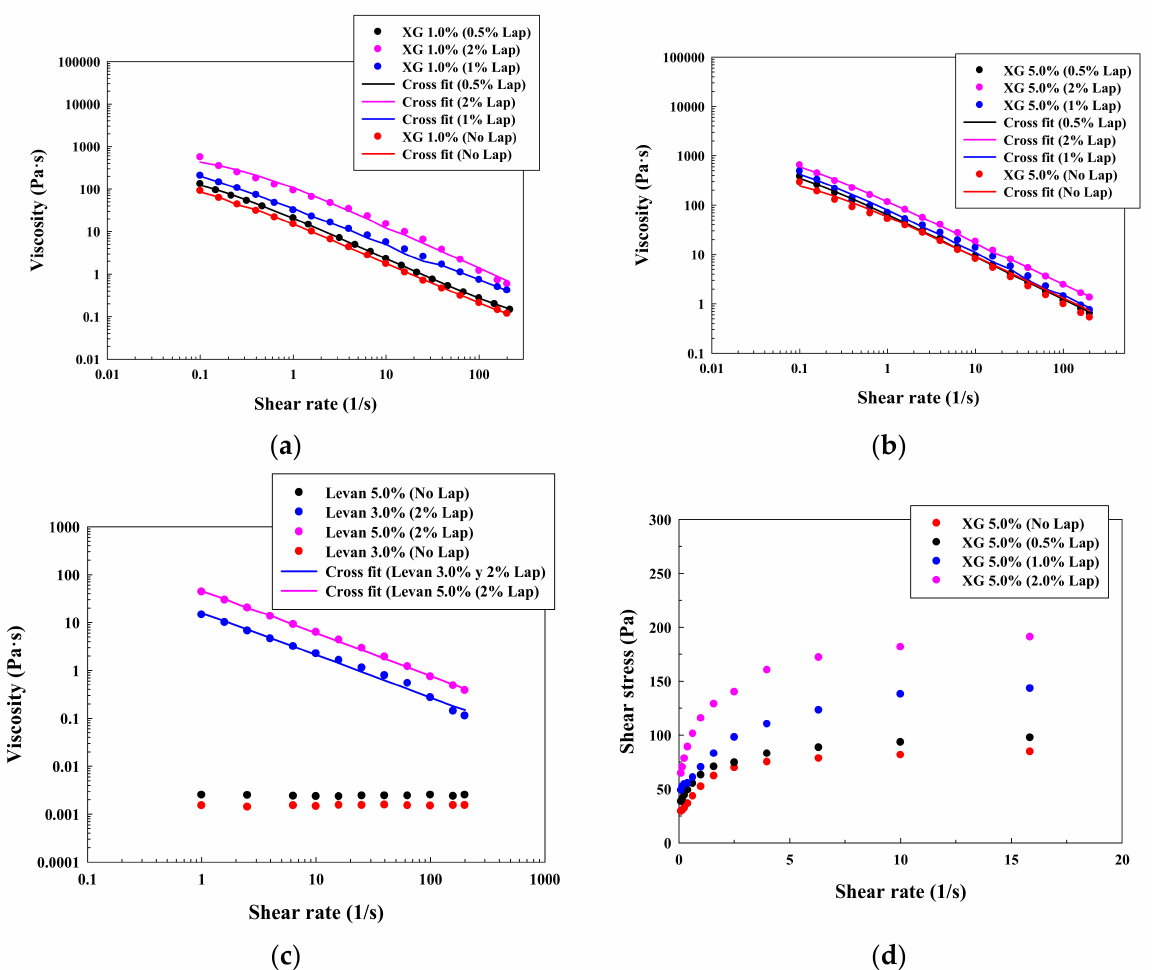
Figure 4. Viscosity-shear rate plots for different polysaccharides solutions with Laponite ® : ( a ) xanthan gum 1.0% w / w ; ( b ) xanthan gum 5.0% w / w ; ( c ) levan with 2.0% w / w Laponite ® ; ( d ) shear stress–shear rate plot for xanthan gum 5.0% w / w at low shear